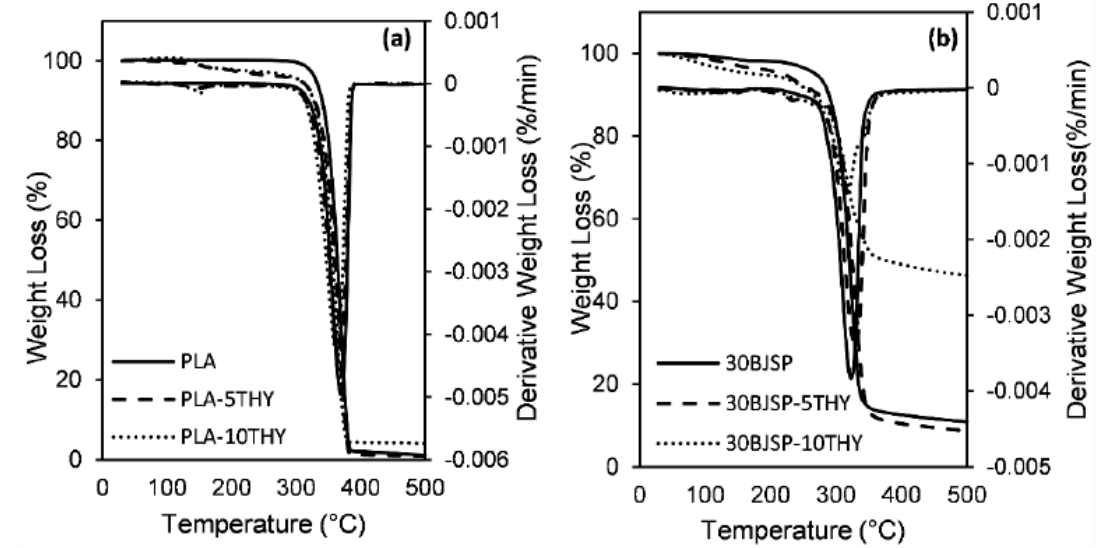
Figure 9. TGA and DTGA curve, ( a ) PLA and its thymol composites and ( b ) 30BSP and its thymol